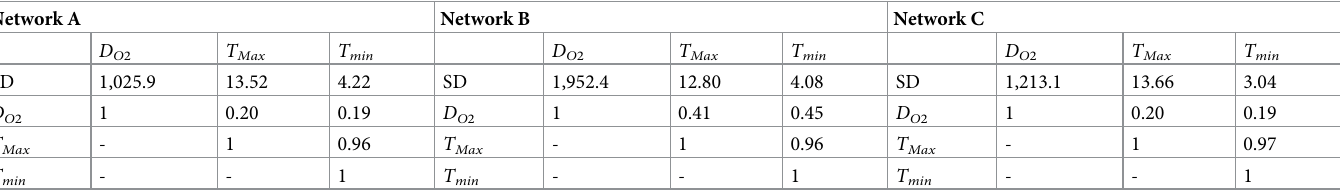
Table 3. Standard Deviation (SD) and Correlations between parameters estimated by BELUGA Genetic Algorithm.